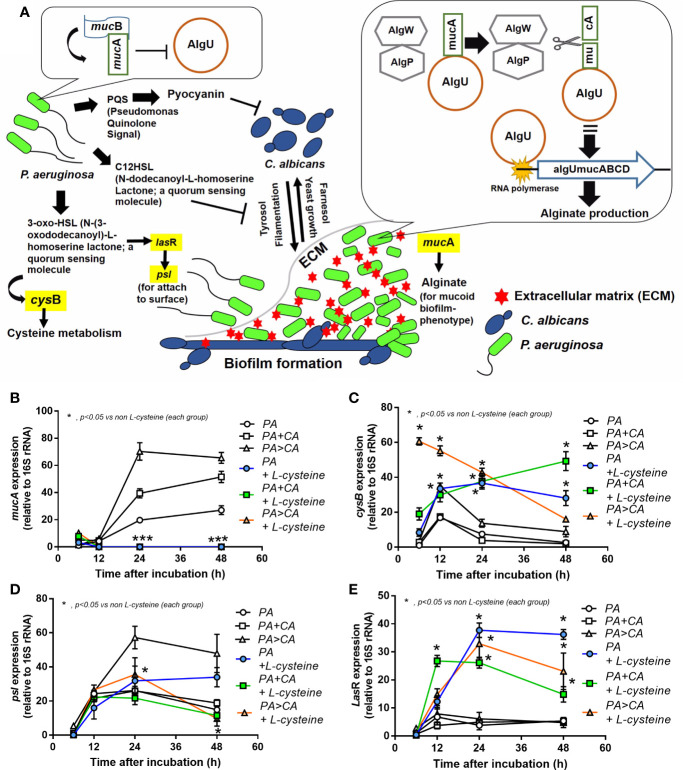
Diagram of some important genes that regulate ECM protein formation (A) demonstrates i) Pseudomonas produces 3-oxo-HSL and several proteins to initiate biofilms (yellow highlights are selected genes to explore in this study) and secretes pyocyanin and C12-HSL to inhibit Candida growth (Kerr et al., 1999), ii) Candida produces Tyrosol and Farnasol for fungal biofilms (Pierce, 2005; McAlester et al., 2008), iii) bacterial attachment on Candida pseudohyphae on mixed-organism biofilms (Fourie et al., 2016), and iv) biofilm inhibition by mucB in planktonic bacteria (left side) and alginate synthesis by AlgU in sessile bacteria (right side) (Schurr et al., 1996). Additionally, expression of some genes from biofilms of P. aeruginosa alone (PA) and PA with Candida by initially simultaneous incubation (P. aeruginosa + C. albicans) or the Candida addition at 24 h biofilm-formed bacteria (P. aeruginosa > C. albicans) with or without l-cysteine (anti-biofilm) (B–E) are demonstrated. Mean ± SE was used for data presentation, and the differences between groups were examined by one-way ANOVA followed by Tukey’s analysis for comparisons of multiple groups or 2 groups (B–E). A p-value of < 0.05 was considered statistically significant. (Independent triplicate experiments were performed.) (*p<0.05; ***p<0.001).